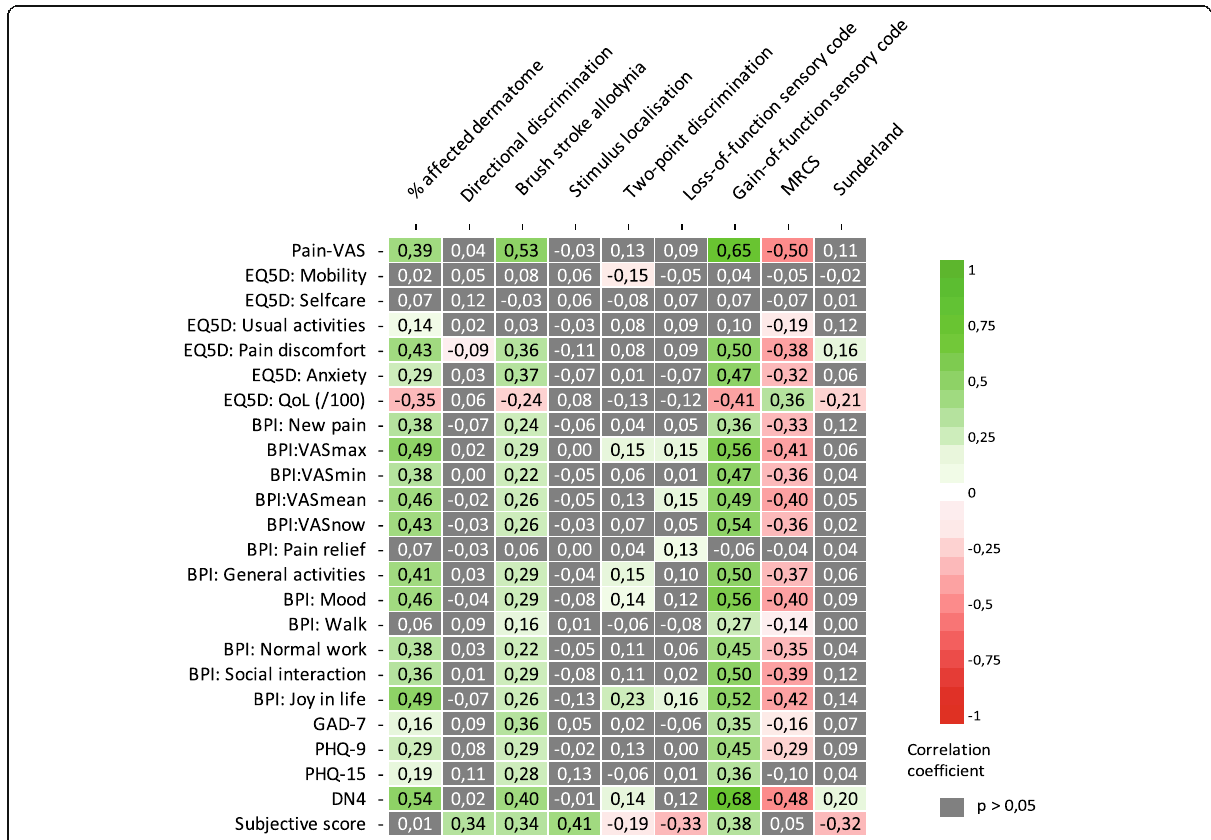
Fig. 5 Correlation between objective (columns) and subjective (rows) neurosensory measurements. Correlation coefficients for significant positive correlations ( P < 0.05) are shown in green. Correlation coefficients of significant negative correlations ( P < 0.05) are shown in red. Non-significant correlations ( P > 0.05) are shown in grey. This figure shows a pattern where generally the size of the affected area, the presence of brush stroke allodynia, and positive symptoms correlated with the different questionnaire scores e.g. Quality of life (EQ5D:QoL) correlated significantly with percentage of affected dermatome, brush stroke allodynia, gain-of-function sensory code, MRCS, and Sunderland. Pain-VAS, GAD-7, and PHQ-9 each correlate significantly with percentage of affected dermatome, brush stroke allodynia, gain-of-function sensory code, and MRCS. PHQ-15 correlated significantly with percentage of affected dermatome, brush stroke allodynia, and gain-of-function sensory code, but not with MRCS. The DN4 scores showed a significant correlation with percentage of affected dermatome, brush stroke allodynia, two-point discrimination, gain- of-function sensory code, MRCS, and